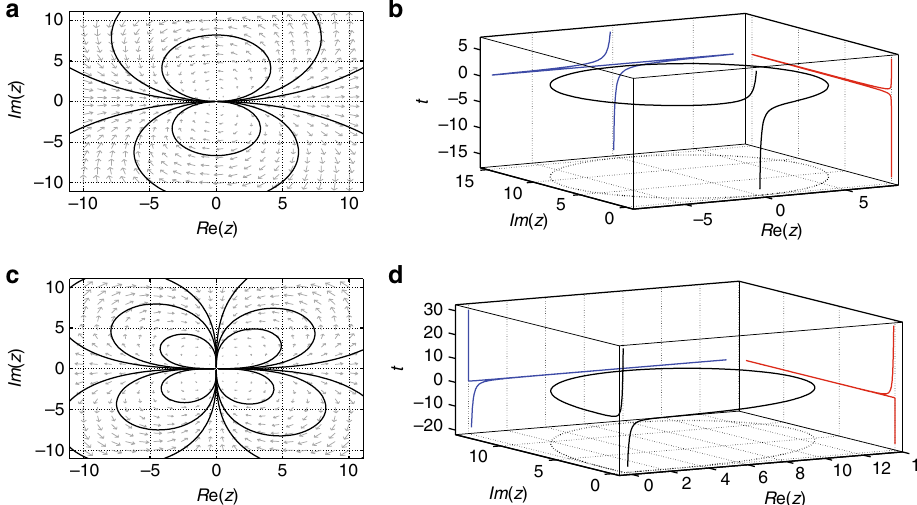
Fig. 4 Complexi fi ed variants of ODE models. a , b The complex dynamics of _ z ¼ z 2 as represented by ODEs of Eq. (19). Phase plane analysis a and sample trajectory b . a Shows that the orbits close (and are, in fact, circles as shown in the text). b Illustrates the circular nature of the projection in the bottom x − y plane, as well as the x − t and y − t plane projections while following the x − y − t composite trajectory. c , d The complex dynamics of the two-degree-of- freedom system with _ z ¼ z 3 . An example from the fi rst quadrant of c is illustrated in more detail in the d , exhibiting how collapse is avoided in this